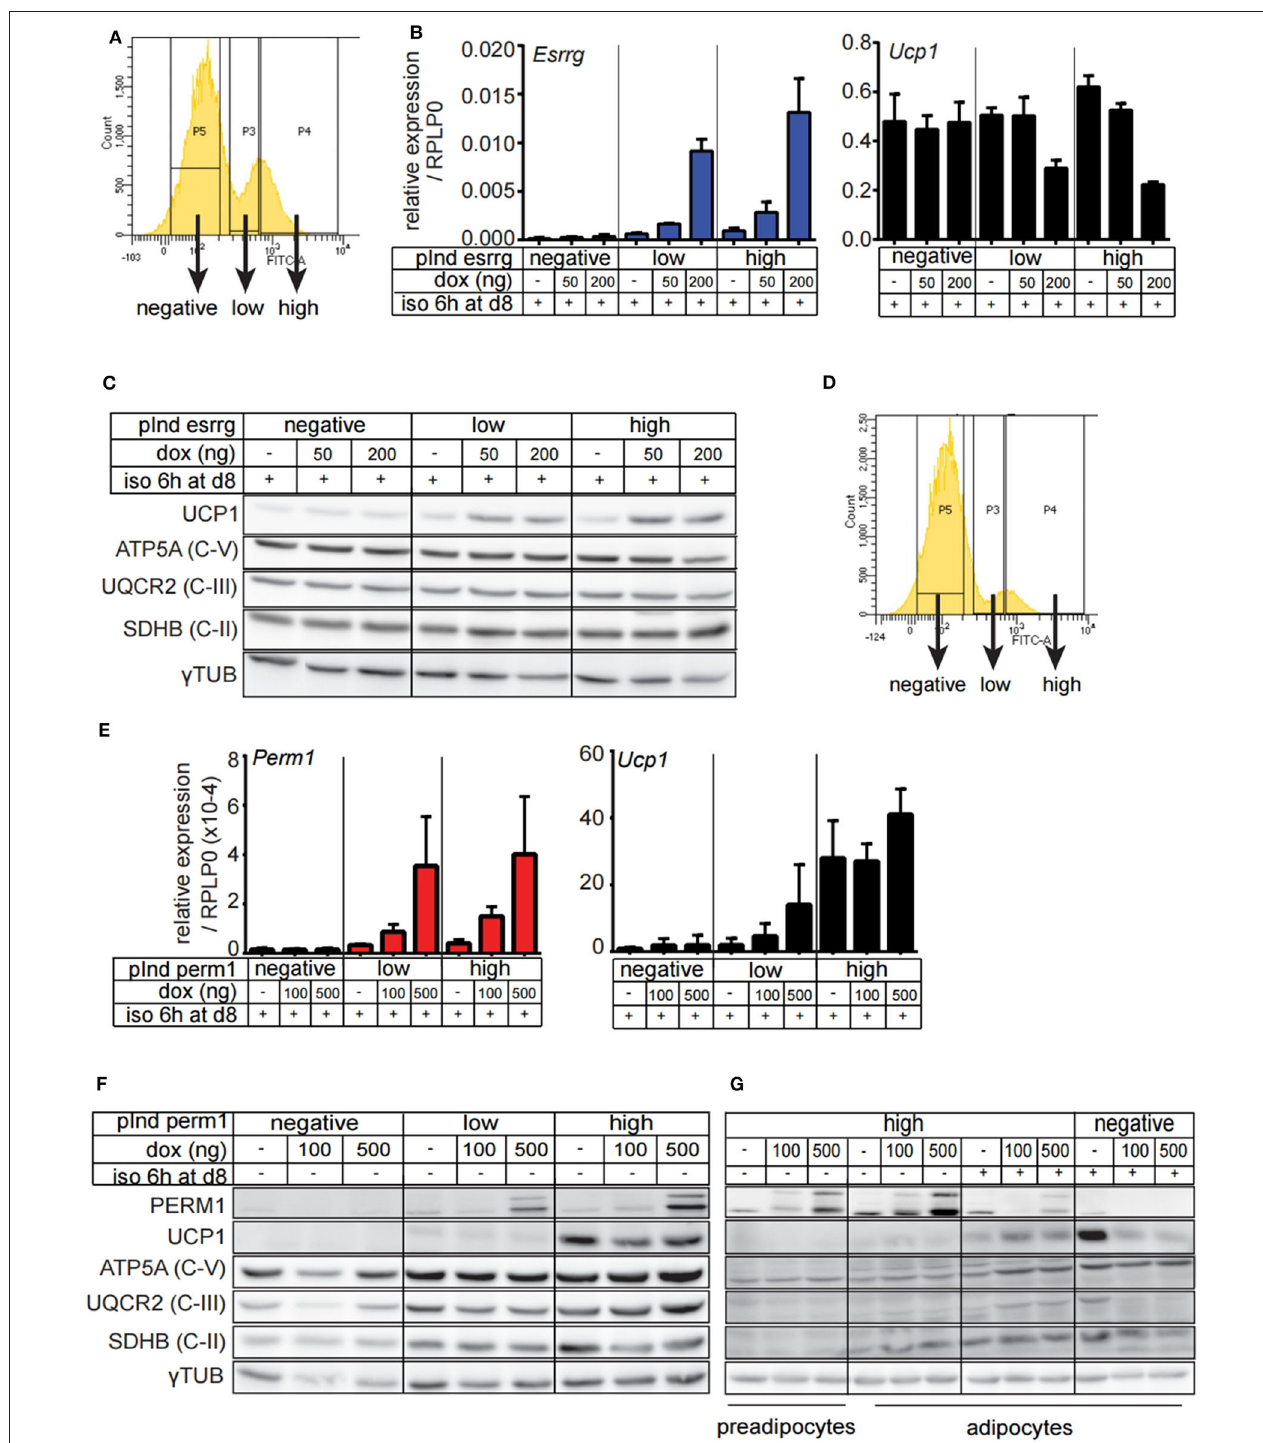
FIGURE 5 | Generation and characterization of brown adipocyte cell lines expressing either ESRRG or PERM1 in a doxycycline dependent manner. (A) Representative FACS plots from immortalized brown pre-adipocytes transduced with lentiviral particles containing pInd21_ESRRG to polyclonally generate new cell lines where ESRRG is not expressed or is lowly or highly induced by doxycycline treatment, respectively. (B) Esrrg and Ucp1 expression in in vitro differentiated